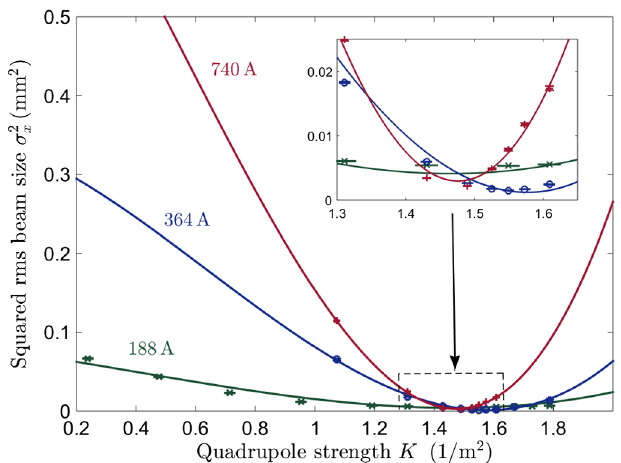
FIG. 5. Quadrupole scan results for the APL operated at 188, 364, and 740 A of total current. Error bars for beam size measurements are included. The fitted emittances can be found in Table